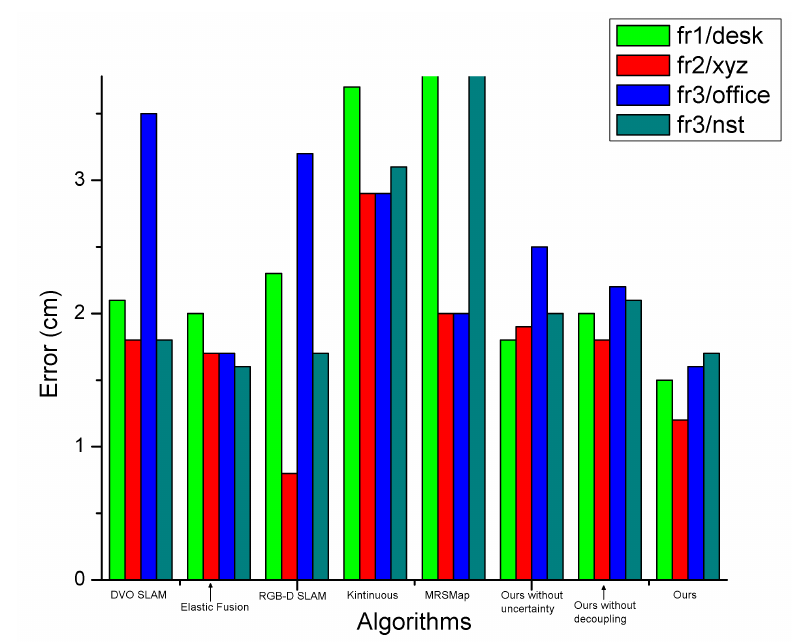
Figure 9. The RMSE of the absolute trajectory error (cm) of our proposed algorithm in comparison to previous methods on the TUM datasets of [10]. The algorithms from left to right are: DVO SLAM [46],